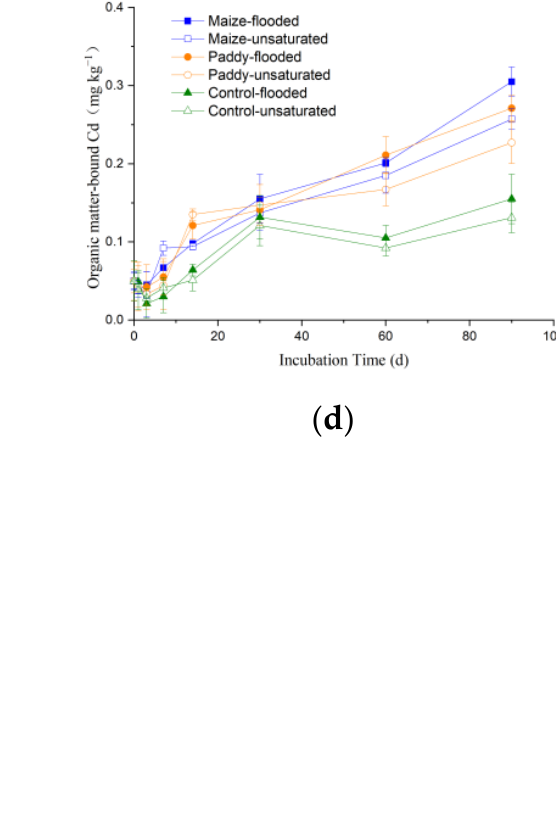
Figure 5. Temporal changes of the content of different Cd fractions (exchangeable Cd ( a ), car- bonate-bound Cd ( b ), Fe-Mn oxide-bound Cd ( c ), organic matter-bound Cd ( d ), and residual Cd ( e )) in the soil collected from site A of high pollution levels during laboratory incubation under different treatments.